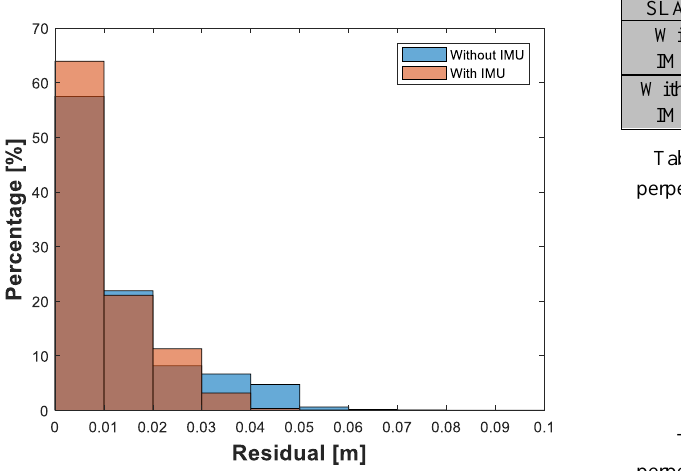
Figure 4. Histograms of the points’ residuals in two cases, SLAM with and without IMU.